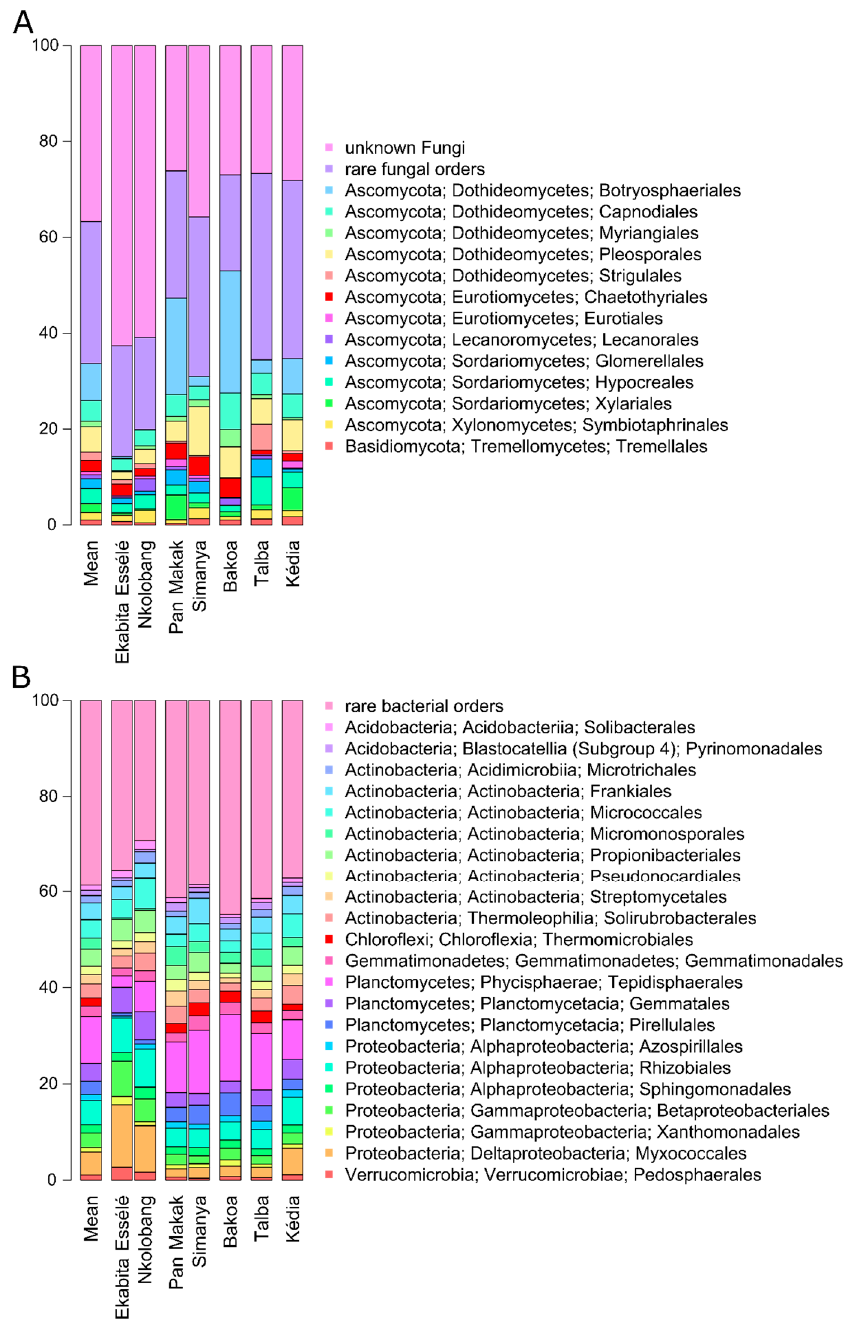
Figure 2. Abundant fungal ( A ) and bacterial ( B ) orders in T. cacao leaves collected in seven different agroforestry management systems in Cameroon. Only orders with an average abundance ≥ 1% (bacteria) or ≥ 0.5% (fungi) in the entire data set are shown.